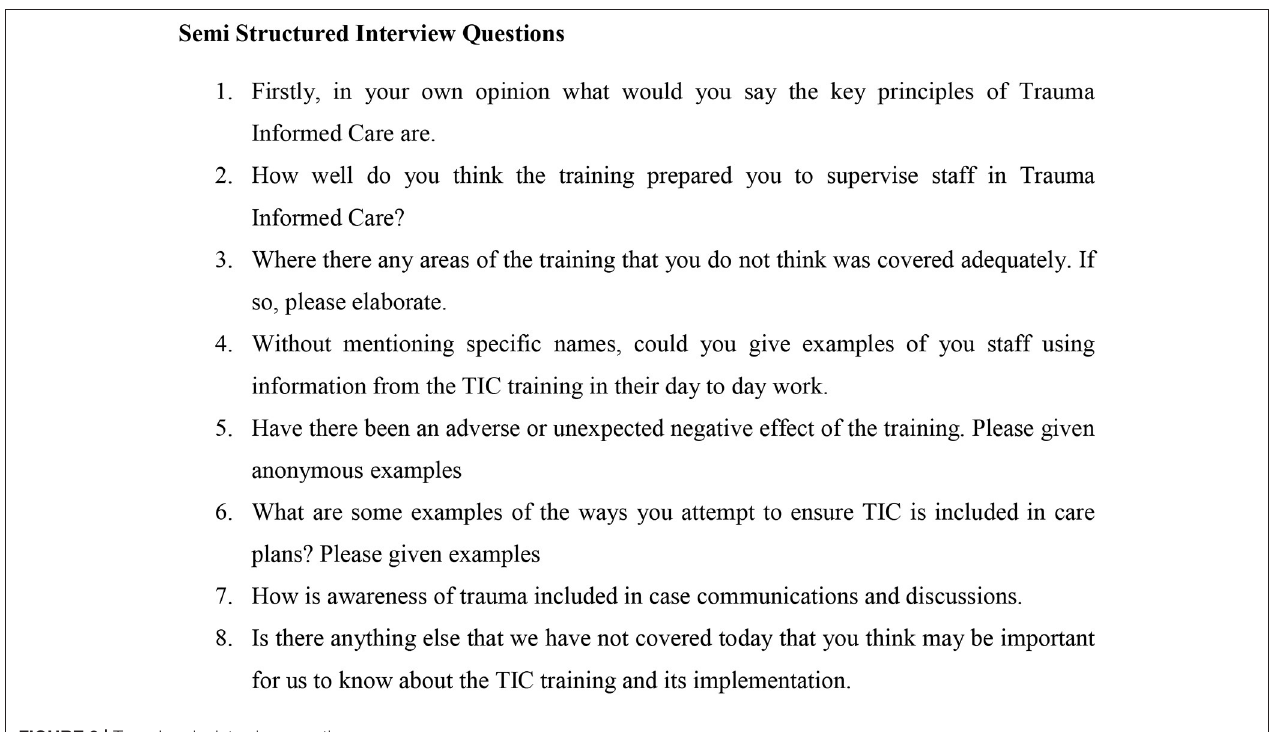
FIGURE 3 | Team Leader interview